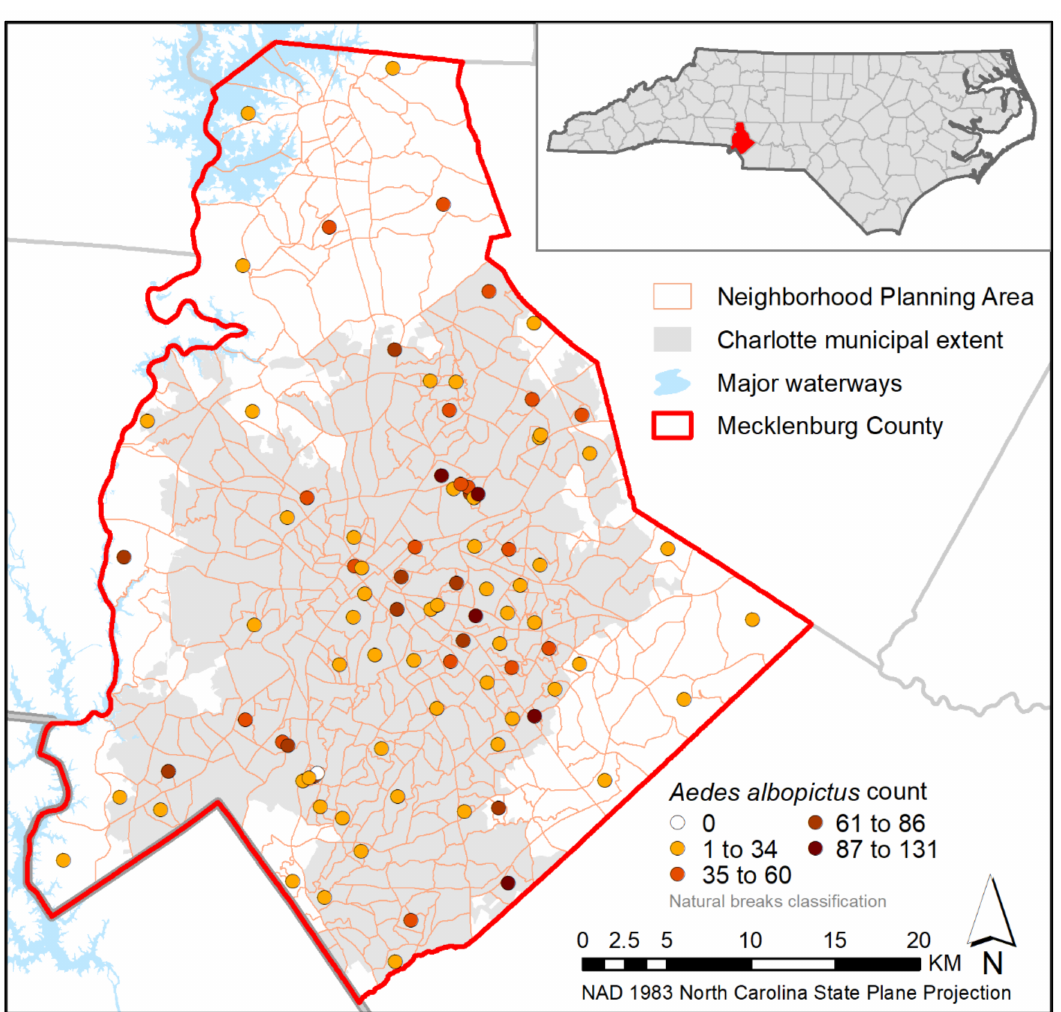
Figure 1. Collection sites in Mecklenburg County, North Carolina. Sites are colored to represent the total number of Ae. albopictus collected at that location during this study. Inset map shows location of Mecklenburg County in North